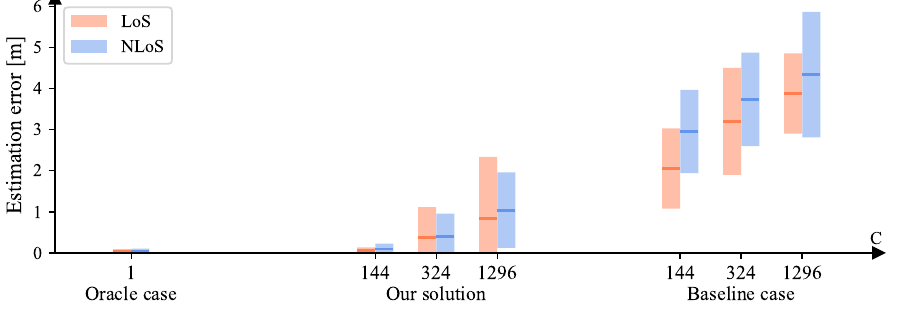
Figure 17. The location-estimation errors of both LoS and NLoS areas for the oracle/baseline cases C = 144/324/1296, A = 51.84, σ = 0 and our solution when { each bar, the middle line is mean ( e ) , i.e., MSE, and its height ranges from MSE std ( e ) . Note that for the oracle case, C always equals 1 for